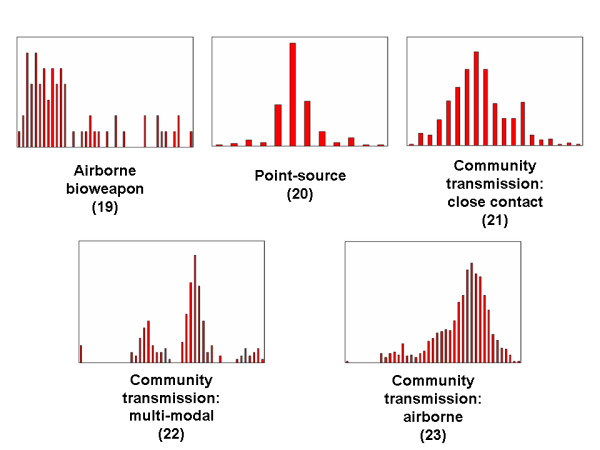
Temporal distributions used for simulating outbreaks, from the epidemic curves of historic outbreaks, with references.